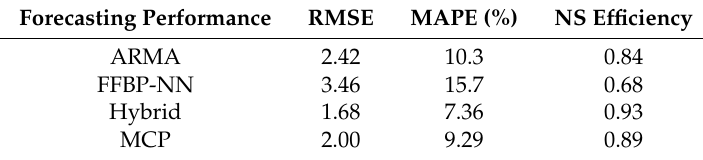
Figure 4. Outcomes of test dataset: ( a , b ) forecasting performance of autoregressive-moving average (ARMA), feed-forward neural network (FFBP-NN), hybrid model and the model conditional processor (MCP). In addition, ( c ) MCP forecast and estimation of its uncertainty and ( d ) 5% probability acceptance limit plot. Table 2. Predictive performance assessment using forecasting statistical terms.